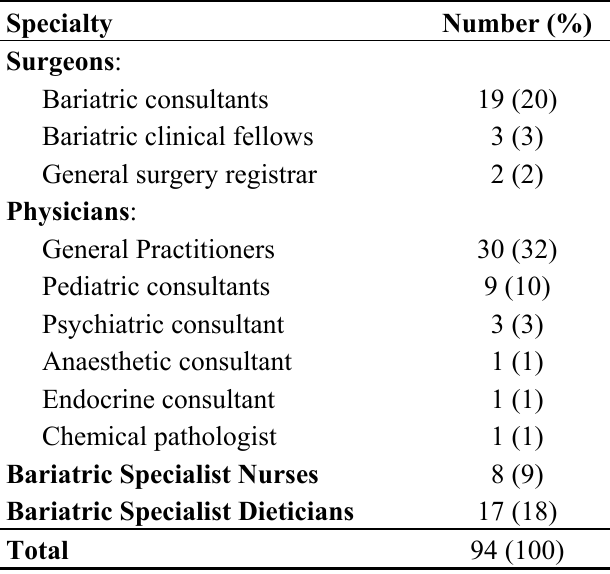
Table 1. Demographics of respondents.